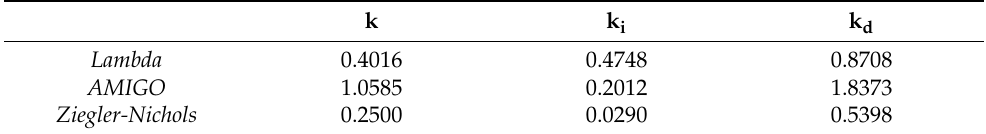
Table 7. PID parameters according to the average values from the step responses with an additional load of 10.8 g.